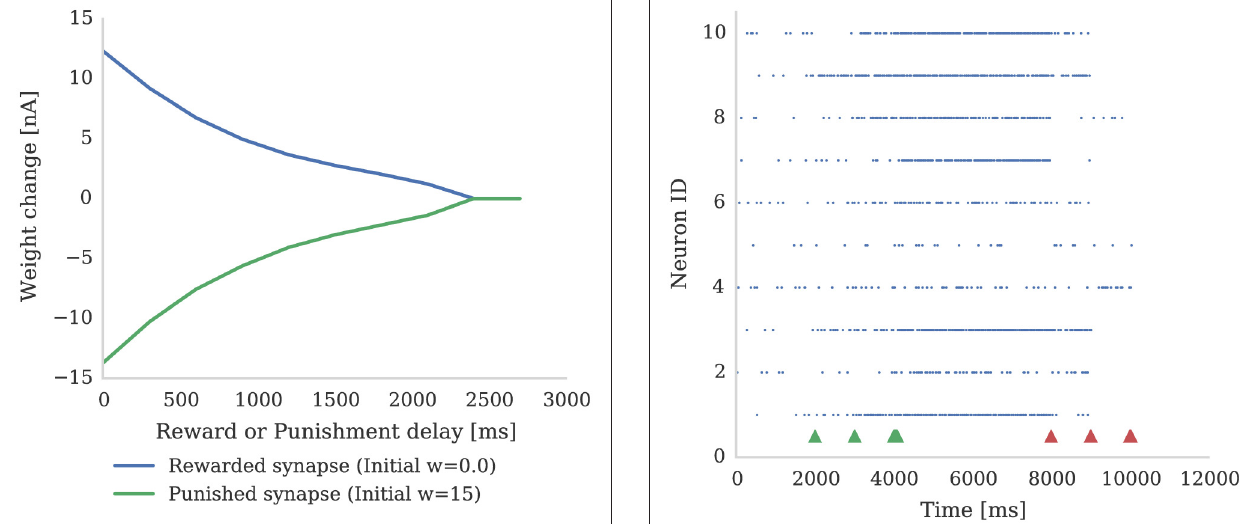
FIGURE 4 | Ten neurons connected to 10 Poisson spike sources, each with a mean firing rate of 50Hz. Dopamine is injected at times 2,000 ms, 3,000 ms, and 4,000 ms (Green markers). This causes potentiation of synaptic connections between stimuli and post-synaptic neurons which causes post-synaptic neurons to respond more strongly. We then apply punishment (negative dopamine value, red markers) at times 8,000 ms, 9,000 ms, 10,000 ms which causes a reduced response to the same random stimuli. The experiment was performed with parameters τ d = 5.0 ms, τ c = 100.0 ms; reward signals were represented using D c = 0.01; and punishment signals using D c = − 0.002. Due to Poissonian stimulus and short timing constants for eligibility and dopamine traces, not all synapses get potentiated. On the other hand, punishment is more effective because spiking rate is higher and thus eligibility traces have non-zero values